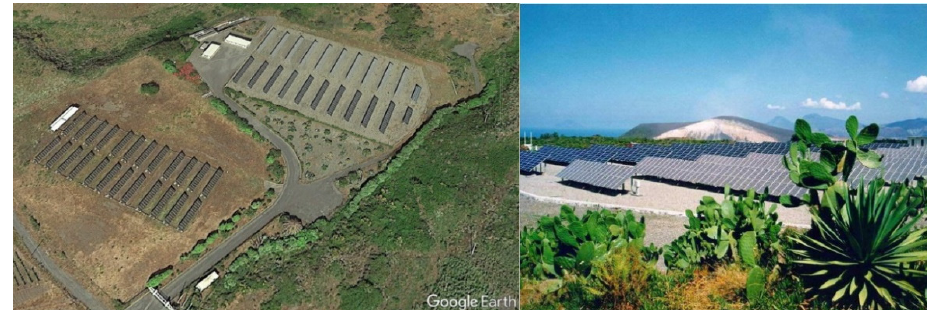
Figure 4. PV plants in Vulcano